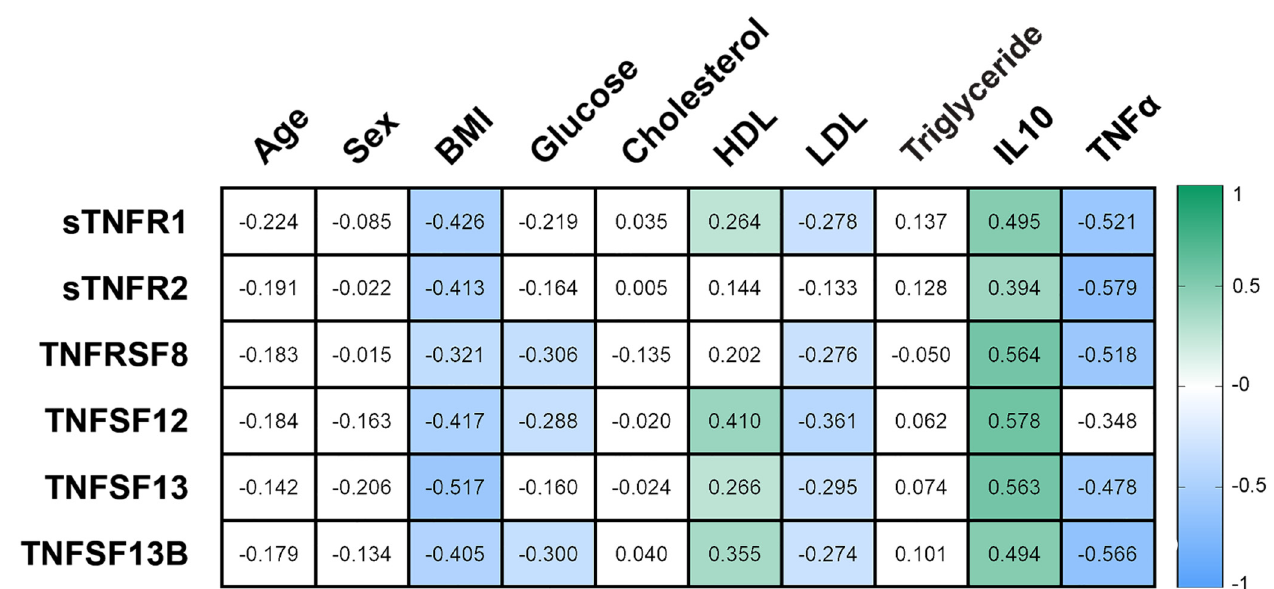
Figure 2. Correlation relationships of sTNF-R1, sTNF-R2, sTNFRSF8, and ligands—TNFSF12, TNFSF13, TNFSF13B with biochemical parameters in all obese patients. Filled squares show significance ( p < 0.05).